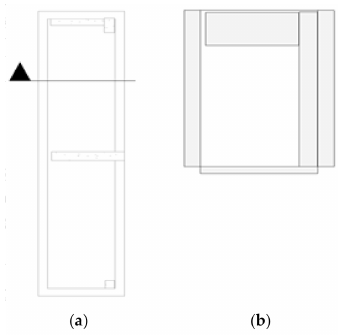
Figure 7. ( a ) Top view and ( b ) sectional view of corridor 2F.